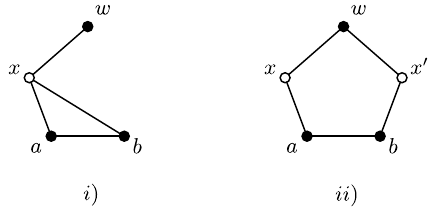
Fig. 1: In the graph G , a a − w path of length 2 and a b − w path of length 2 have either i ) two common vertices, i.e., w, x or ii ) only one common vertex w